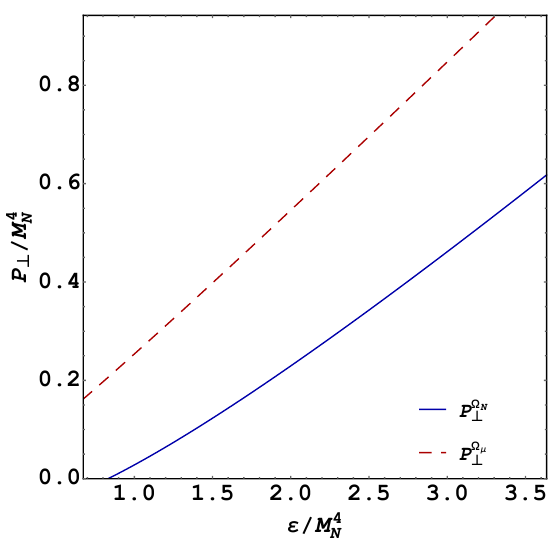
Figure 3. (Color online) Equations of state for the perpendicular pressure versus energy density. With Ω QFT contribution (continuous line) and without (dashed line). The magnetic field under consideration is B = 10 16 G.